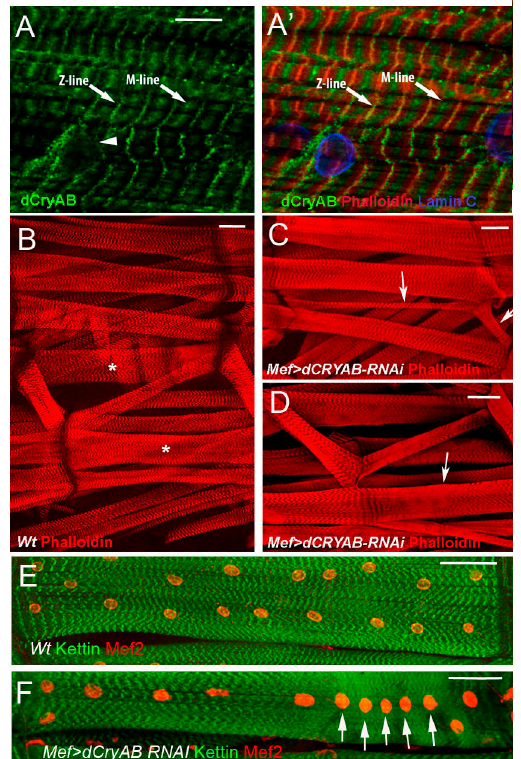
Figure 5. dCryAB localization in sarcomeres of larval body wall muscles and effects of muscle specific attenuation of dCryAB . ( A , A ′ ) dCryAB is localized in Z-line, M-line, and in the perinuclear area (arrowhead) of the muscle fiber. Scale bar, 10 µm. ( B ) Wild type muscle pattern from 3rd instar larvae revealed by the phalloidin staining. Asterisks in B mark muscles that are affected in ( C , D ). ( C ) Muscle splitting and ( D ) affected sarcomeric pattern in 3rd instar larvae with attenuated expression of dCryAB are indicated by arrows. ( E ) Wild type nuclei pattern in ventral VL3 muscles revealed by Mef2 antibody staining. ( F ) Nuclei clustering (arrows) observed in VL3 muscle from Mef > dCryBRNAi larvae. Scale bars, 20 µm.